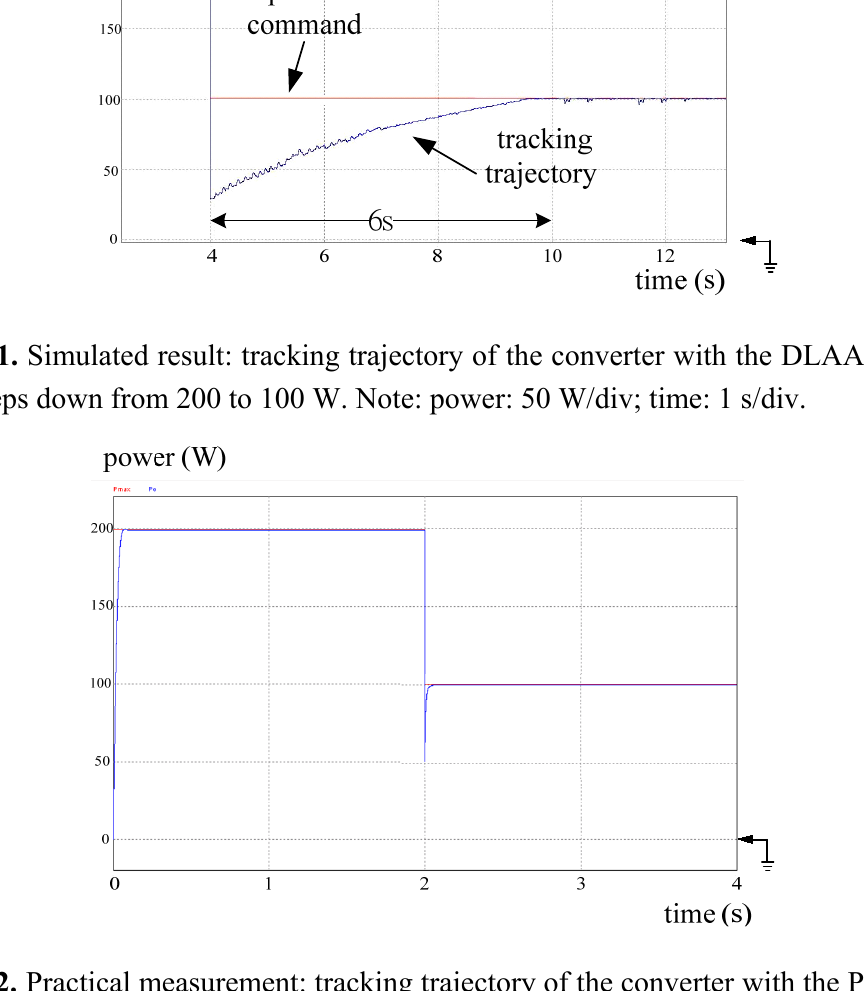
Figure 22. Practical measurement: tracking trajectory of the converter with the POM while PV power steps up from 100 to 200 W. Note: power: 50 W/div; time: 1